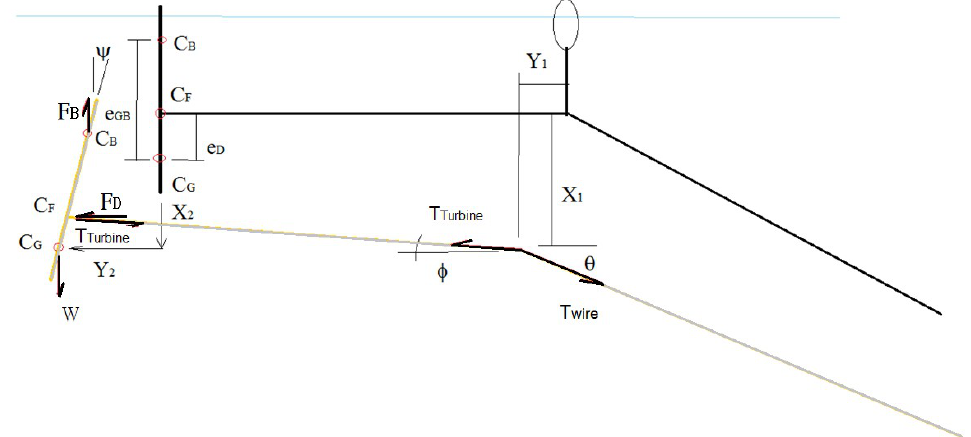
Figure 2. Concentrated mass model of the ocean current turbine system subjected to wave currents.